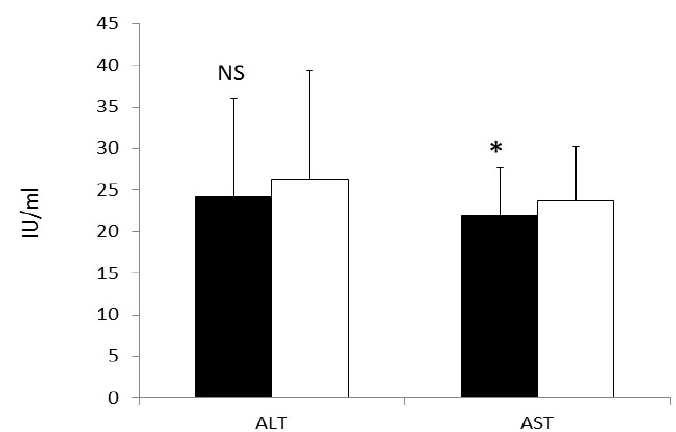
Figure 3. Concentrations of liver enzymes after the egg (dark bar) and the oatmeal (white bar) periods. ALT did not differ between treatments; However, AST was significantly reduced ( p < 0.05) after the egg period (21.9 ± 5.8 vs . 23.7 ± 6.4